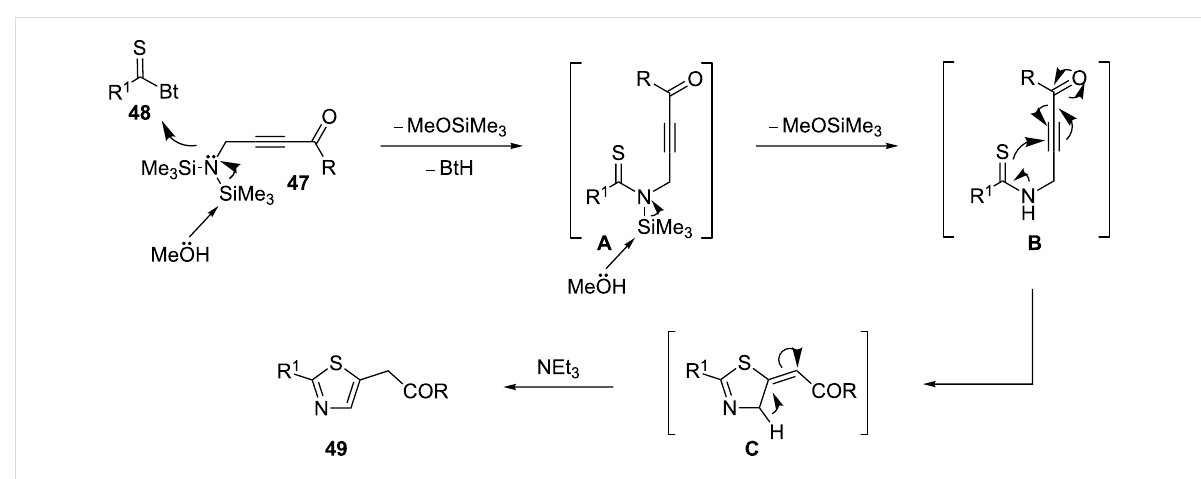
Scheme 14: Mechanism proposed to explain the synthesis of 2,5-disubstituted thiazoles 49 developed by